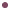
Information entropy and flux though the metabolic network predicted by various methods.(A) and (B) show the information entropy of the flux configurations for S. cerevisiae and E. coli, respectively. For each time point, MaxEnt predictions always have greater information entropy compared to MinFlux and Geometric. (C) and (D) show the total flux of the metabolic configurations predicted for S. cerevisiae and E. coli, respectively. MaxEnt predicts larger total flux compared to the other two methods, as the later rely on the minimization of fluxes assumption. Data points are color coded as • MaxEnt, • Geometric, and • MinFlux. Δ corresponds to mutated strains overproducing acetate.